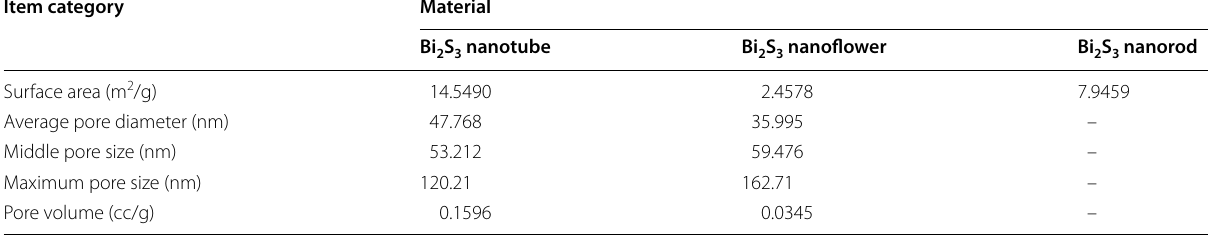
S samples with different morphologies 2 3